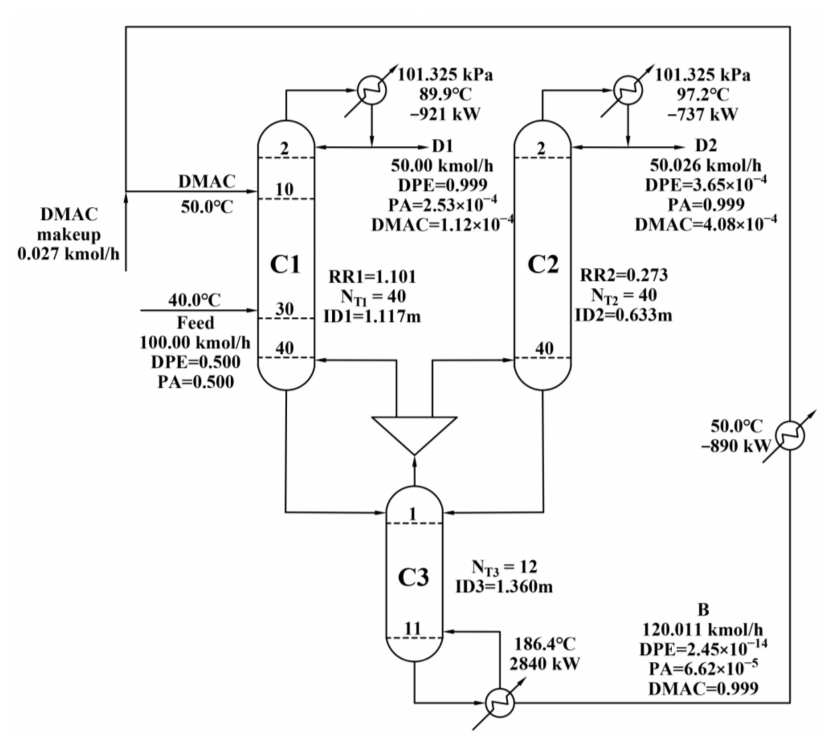
Figure 6. Optimal process flow diagram of the